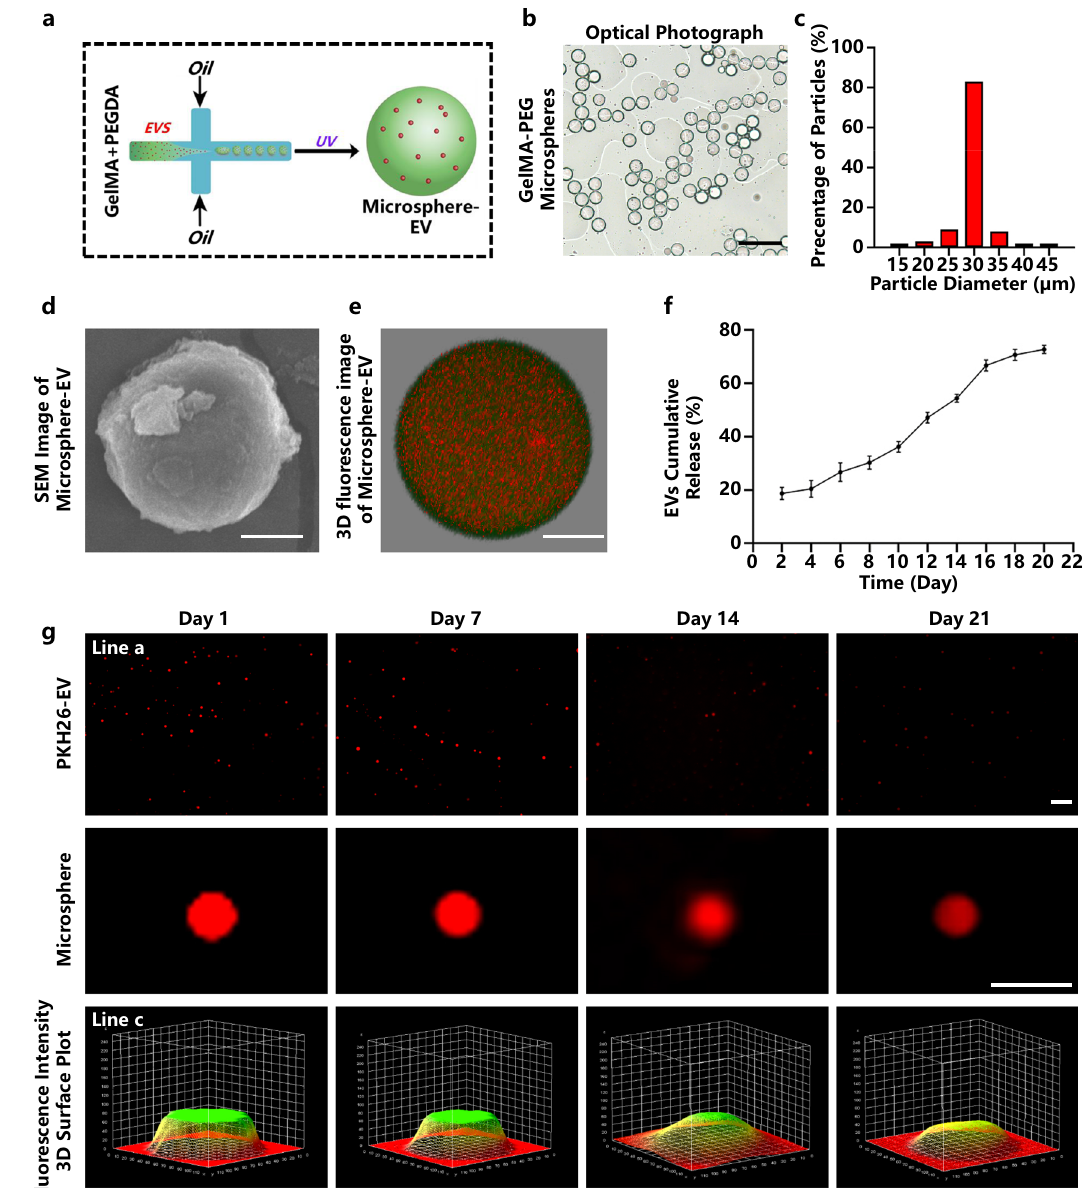
Fig. 4 | Preparation andcharacterizationofgelatin methacryloyl-polyethylene glycol (GelMA-PEG) microspheres. a Schematic diagram of the preparation principle of GelMA-PEG microsphere-encapsulated EVs. This Figure was created with BioRender.com. b Optical photograph of GelMA-PEG microspheres. Scale bar=100 μ m. c Particle size analysis of the microspheres. d Scanning electron microscopy (SEM) image of GelMA-PEG microspheres. Scale bar=10 μ m. e Three- dimensional fl uorescence image of EV-encapsulated microspheres taken by con- focal microscopy. Microspheres ( fl uorescein isothiocyanate (FITC) labeled, green fl uorescence), EVs (1,1 ’ -dioctadecyl-3,3,3 ’ ,3 ’ -tetramethylindocarbocyanine perchlorate-labeled (PKH26-labeled), red fl uorescence), scale bar=10 μ m. f The release pro fi le of extracellular vesicles from microspheres was detected by